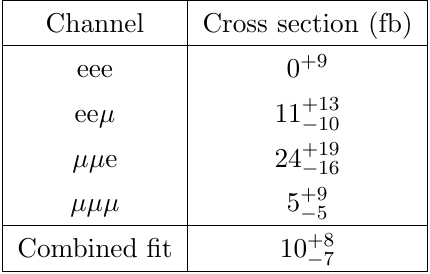
Table 4 . The measured cross sections, together with their total uncertainties, for the individual channels and the channels combined for the BDT-based